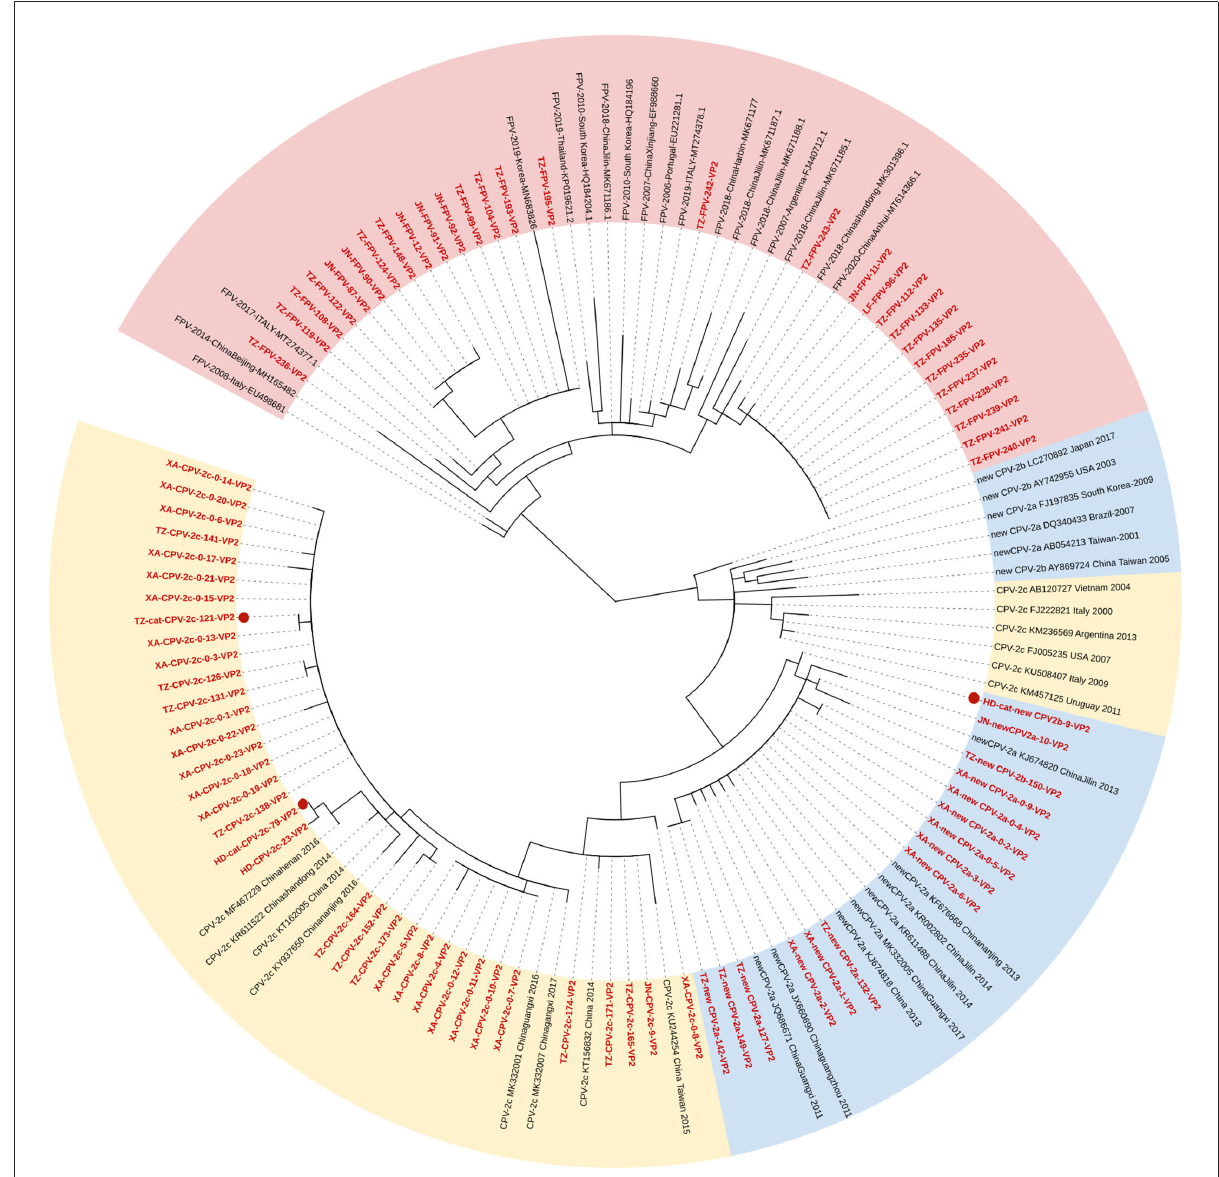
FIGURE1 Phylogenetic tree based on a comparison of the structural (VP2) gene of canine parvovirus type 2 (CPV-2) and feline panleukopenia virus (FPV). Phylogenetic relationships were calculated using the maximum likelihood (ML) method. Gaps were handled by pairwise deletion and bootstrap values were calculated from 1,000 replicates. Strains analyzed in this study are marked in red and reference strains are marked in black. CPV-2 strains isolated from cats in this study are marked with “ .” The monophyletic clusters of new CPV-2a/2b are marked in blue (Clade IIA), the monophyletic clusters of CPV-2c are marked in yellow (Clade IIB), and the monophyletic clusters of FPV are marked in pink (Clade